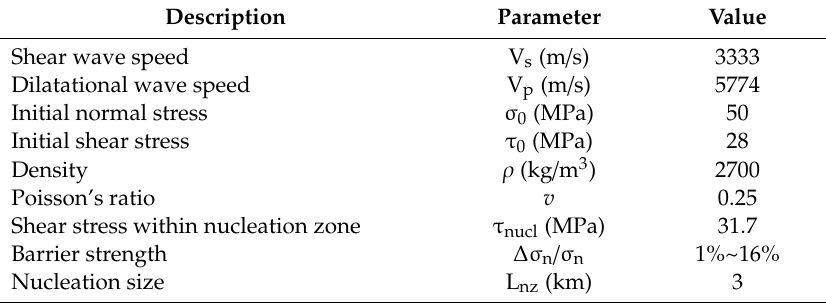
Table 1. Model parameters used in